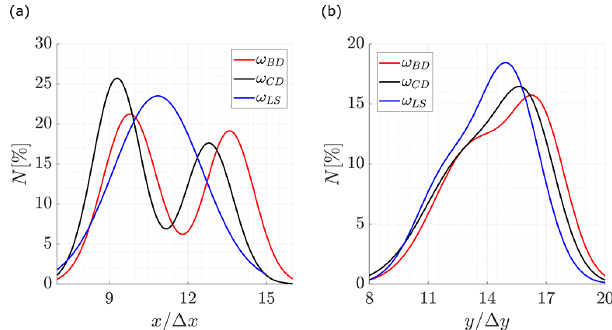
Figure 15. Probability distribution of the vortex center locations while the vorticity VIM is applied using BD, CD and LS schemes. (a) Streamwise direction. (b) Lateral